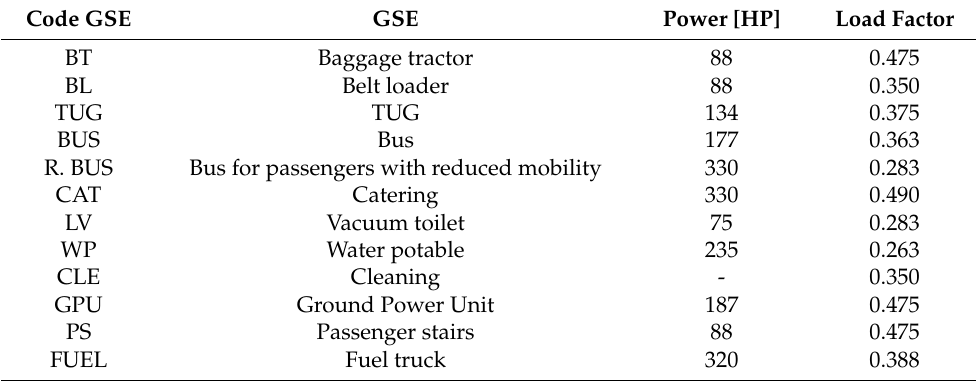
Table A1. Maximum powers studied from observed GSE models and load factors in